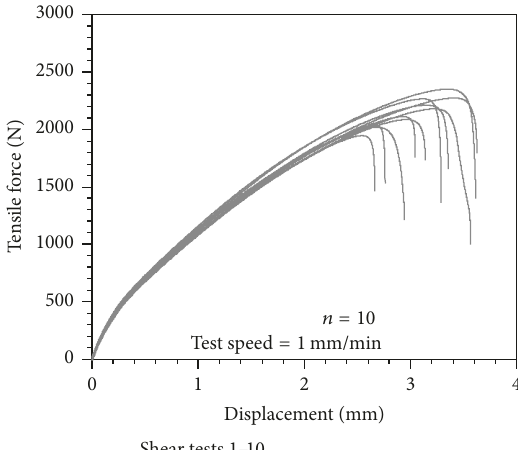
Figure 10: Tensile force of PA66—HDPE test specimen based on form fit, produced by prestructuring joining partner A (PA66) and subsequent welding with joining partner B (HDPE).